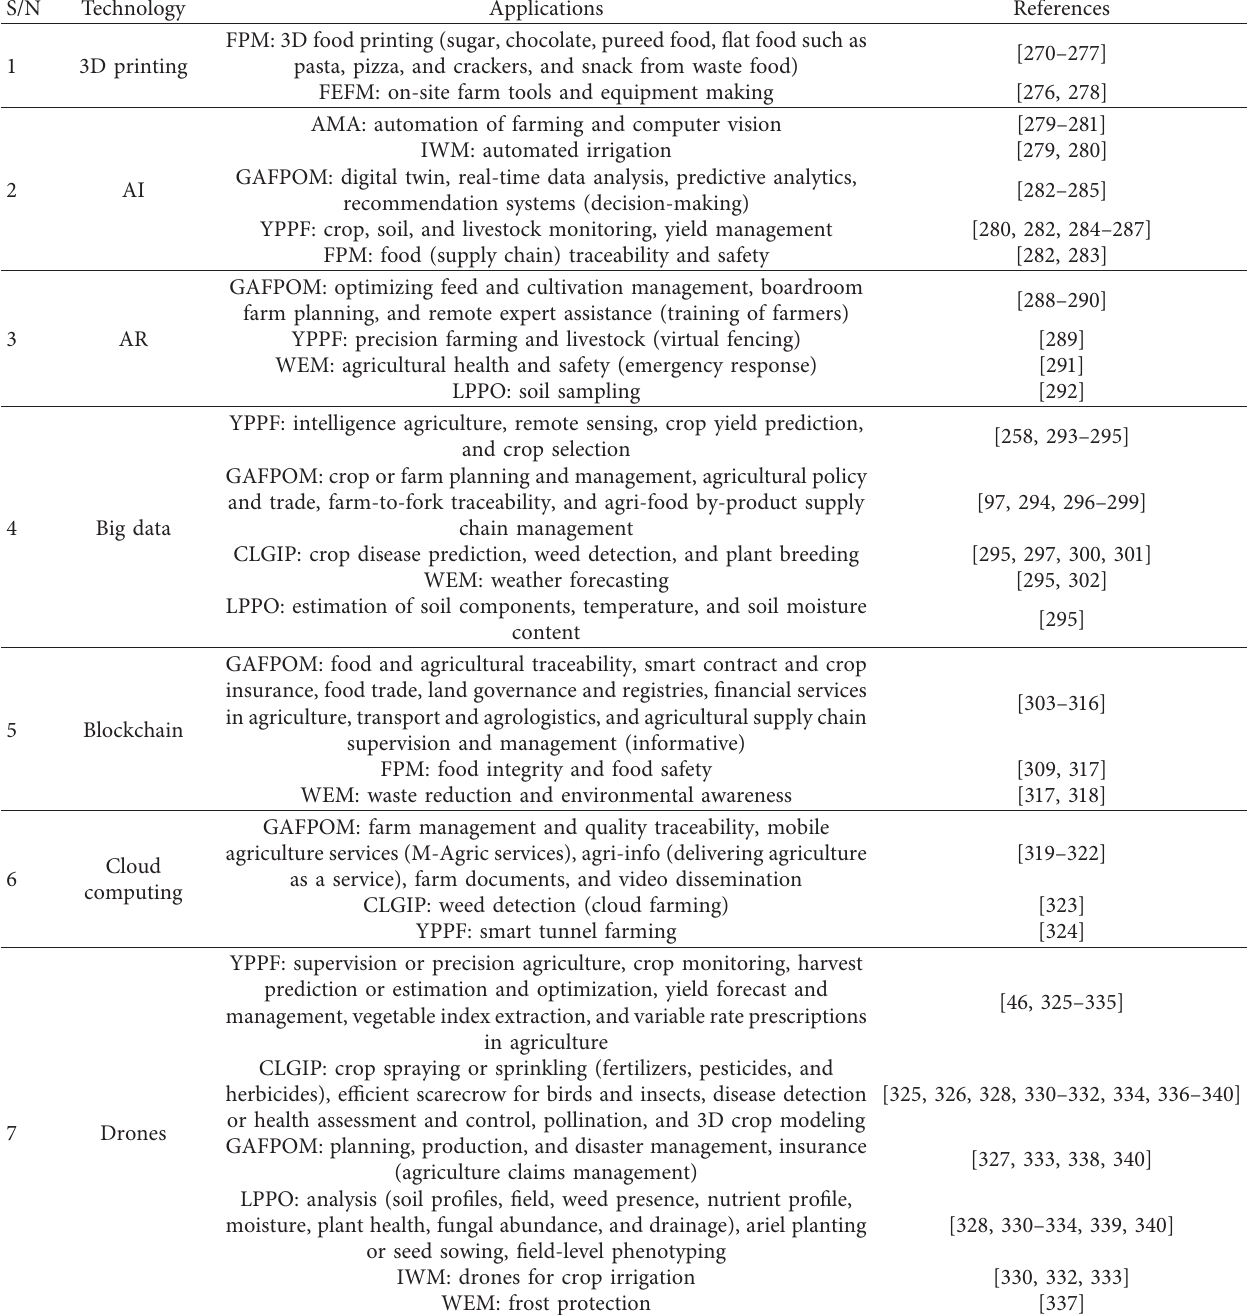
Table 6: Industry 4.0 technology applications in the agriculture and food system. S/N Technology